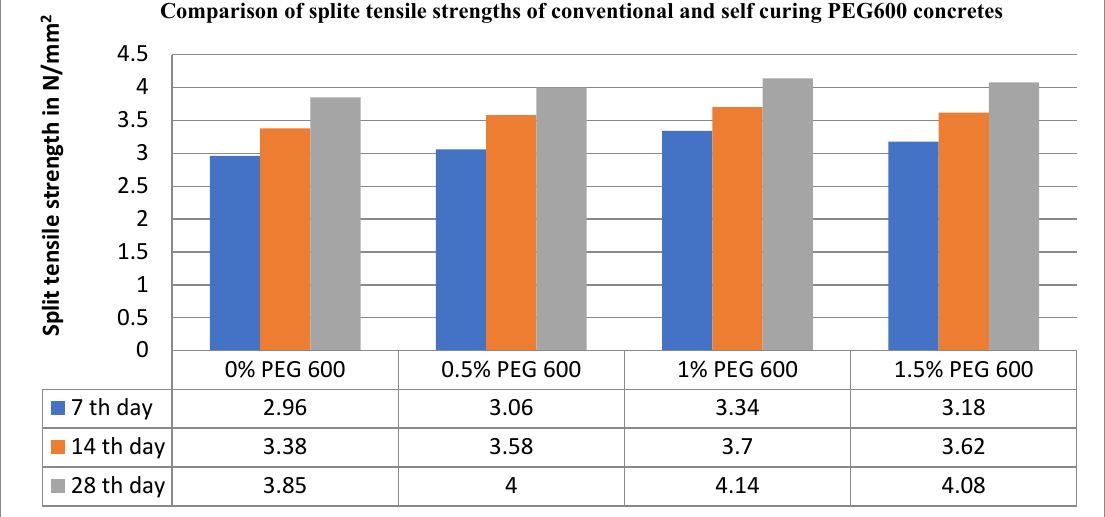
Figure 6. Comparison of split tensile strengths of Conventional and PEG-600 concretes. For conventional and self-curing polyethylene glycol (PEG-600) concretes, the split tensile strength values recorded on 7th, 14th, and 28th days, respectively, are given in Figure 6. It can be observed that the split tensile strength of 1% polyethylene glycol (PEG -600) is more than that of other percentages. That is, the maximum strength is achieved with the addition of 1% polyethylene glycol (PEG-600), and this gained a split tensile strength of 4.14 N/mm 2 . It can be observed that split tensile strength also increases by 7.5% in self-curing concrete. The PEG-600 of self-curing concrete yields significant compressive, flexural, and split tensile strengths. The PEG-600 of the self-curing process does not re- quire the continuous availability of water in concrete. Additionally, the PEG-600 increases the cement hydration and it creates a good bond in low voids and pores. 3.3.1. Scanning Electron Microscopy (SEM) Test The hydration process of concrete results in the development of empty pores and a decrease in the relative humidity of the concrete. This is caused by chemical shrinkage. This results in the concrete mixture drying up on its own and a lack of available moisture. Additionally, it causes the formation of porous structures and microscopic cracks, which are the weak points in the concrete. So, self-curing is used to keep the temperature and humidity stable and stop self-desiccation. The microstructures of both conventional and self-curing polyethylene glycol (PEG- 600) concretes are determined by SEM analysis. The results of SEM analysis conducted on conventional concrete and water-soluble polymer as self-curing concrete are shown in Figure 7a,b, respectively.